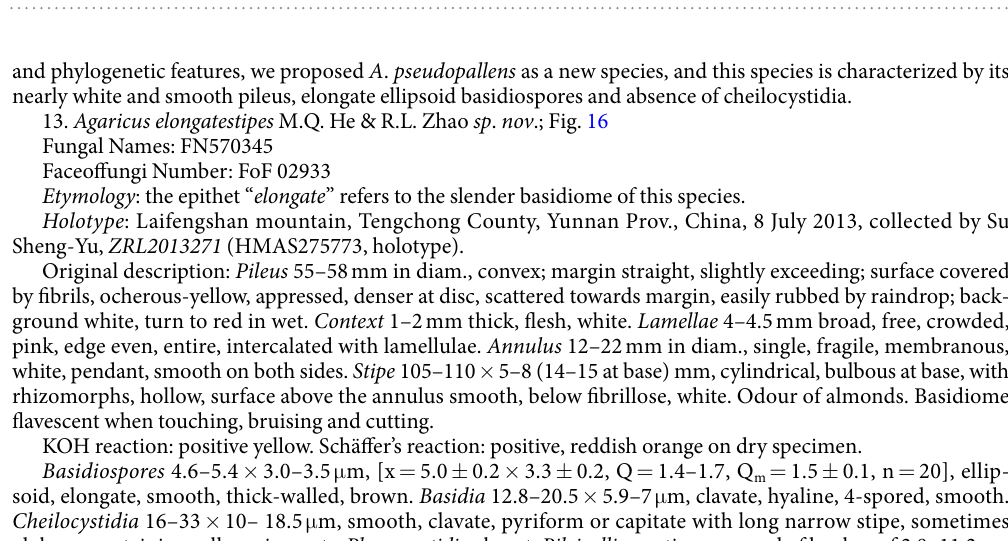
Figure 15. Morphology of Agaricus pseudopallens ( ZRL20151552 , holotype), ( A – C ): Basidiome in field ( A , B ): ZRL20151549 ; ( C ): ZRL20151552 ), ( D ): Basidia ( E ): Basidiospores, and ( F ): Pileipellis